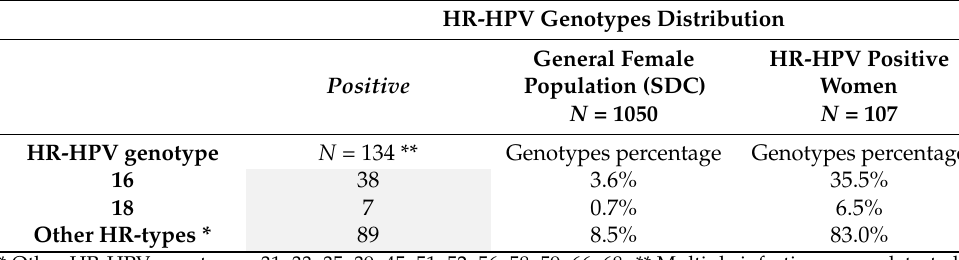
Table 8. HPV type-specific prevalence among women in SDC ( N = 1050) and genotypes distribution in HR-HPV positive women ( N = 107). HR-HPV Genotypes Distribution HR-HPV Positive General Female Positive Women Population (SDC) N = 107 N = 1050 HR-HPV genotype N = 134 ** Genotypes percentage Genotypes percentage 16 38 3.6%